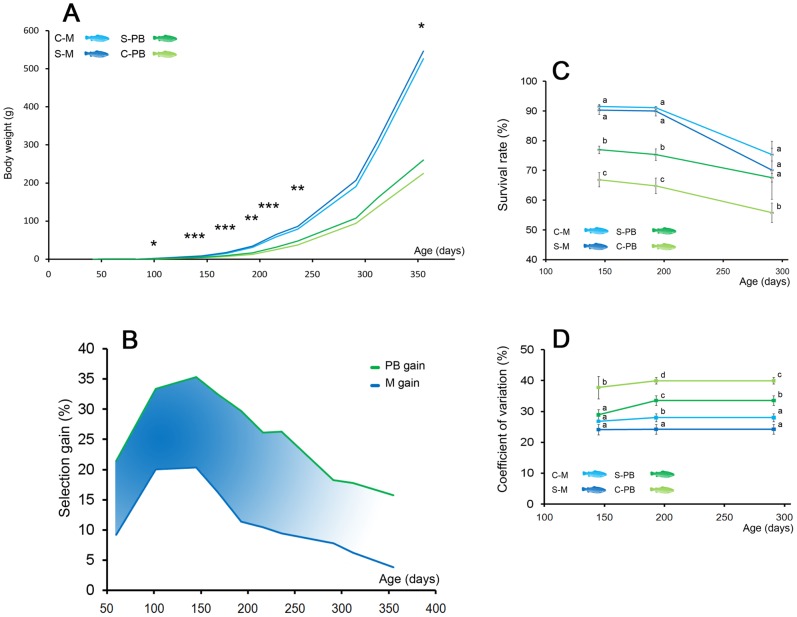
Effects of selection on survival and growth performances.(A) Ten successive weight measurements were carried out during the first year of life. Growth curves are shown for the four line x diet combinations. Stars denote the significance of the diet*line interaction for body weight at every date of measurement (*: P<0.1; **: P<0.05; ***: P<0.01). (B) Selection gain for body weight (%) is calculated for fish fed with a plant-based (PB) diet (green line) and fish fed with a marine diet (blue line). The difference between the two gains is the PB diet-specific selection gain for the ability to grow when fed with a plant-based diet after one generation of selection. (C) The survival rate (%) was significantly higher in selected fish when fed PB diet when there was no difference between selected and unselected population when fed M diet. Different letters mean significant differences (P<0.05) between groups. (D) The coefficient of variation of body weight (%) was higher in groups of fish fed the PB diets throughout the trial, but was significantly reduced by selection in the case of the PB diet. Different letters mean significant differences (P<0.05) between groups.